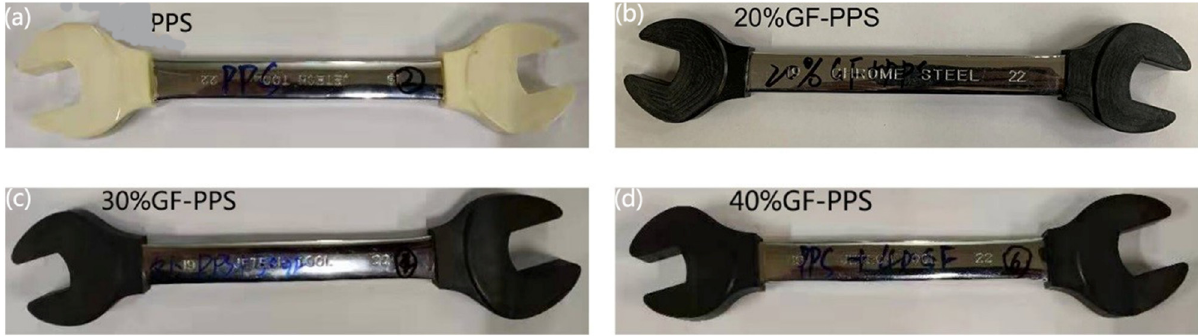
Figure 14: Digital photos of polymer sleeve obtained from di ff erent polymer injection molding of spanner head: ( a ) PPS, ( b ) 20% GF/PPS, (